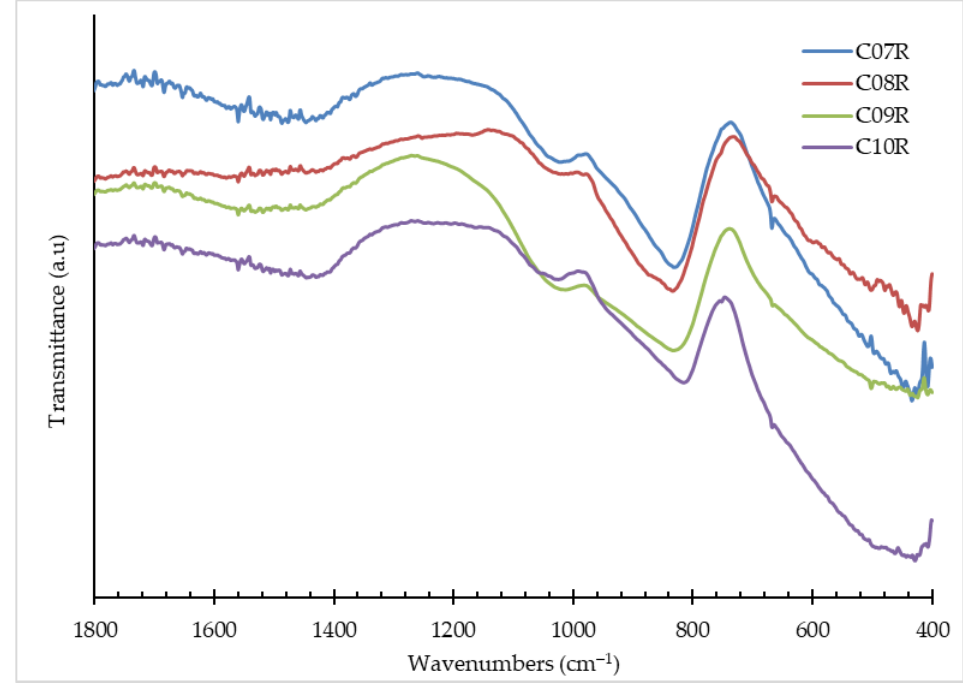
Figure 2. The IR spectrum of the reduction product with the basic ingredients of carbonization at temperatures of 700, 800, 900, and 1000 °C (C07R – C10R). Table 2. Comparison of IR absorption on samples of reduction products from variations in the basic ingredients of rice husk char.